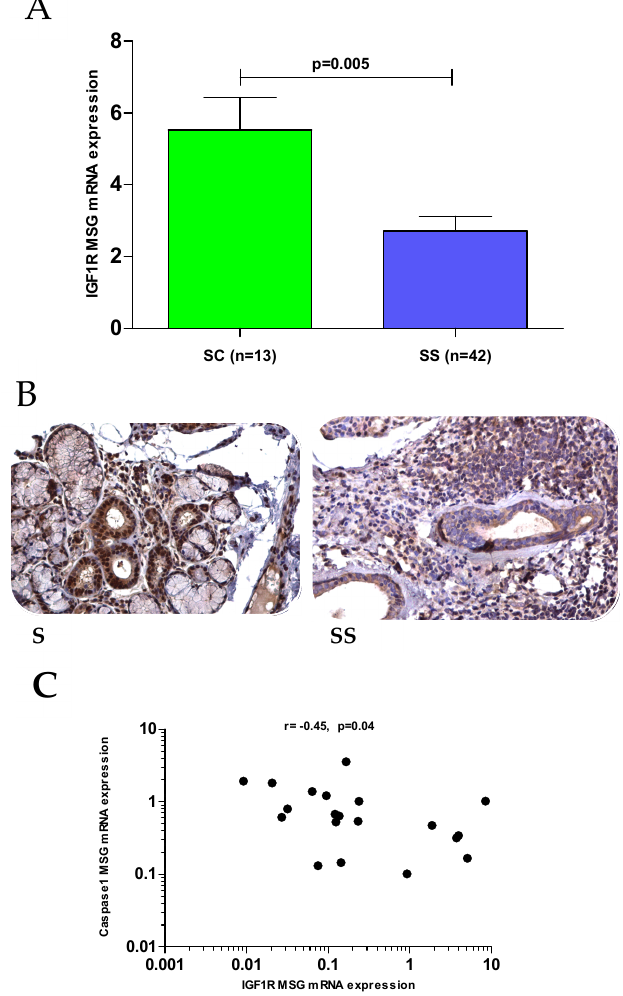
Figure 2. IGF1R mRNA (measured by real-time PCR) and immunohistochemical expression in SC vs. SS patients. ( A ) IGF1R transcript levels were significantly lower in MSG tissues derived from SS patients compared to SCs (2.7 ± 2.7 vs. 5.5 ± 3.2, p = 0.005). ( B ) Representative images depicting reduced IGF1R immunohistochemical expression in salivary ducts and acini of MSG tissue sections from a patient with SS compared to SCs (40×). ( C ) Negative correlation between IGF1R transcripts caspase 1 mRNA expression in MSGs derived from SS patients (r = −0.45, p = 0.04). SS: Sjogren’s syndrome; MSG: minor salivary gland; IGF1R: insulin growth factor receptor 1; r: Spearman’s correlation.